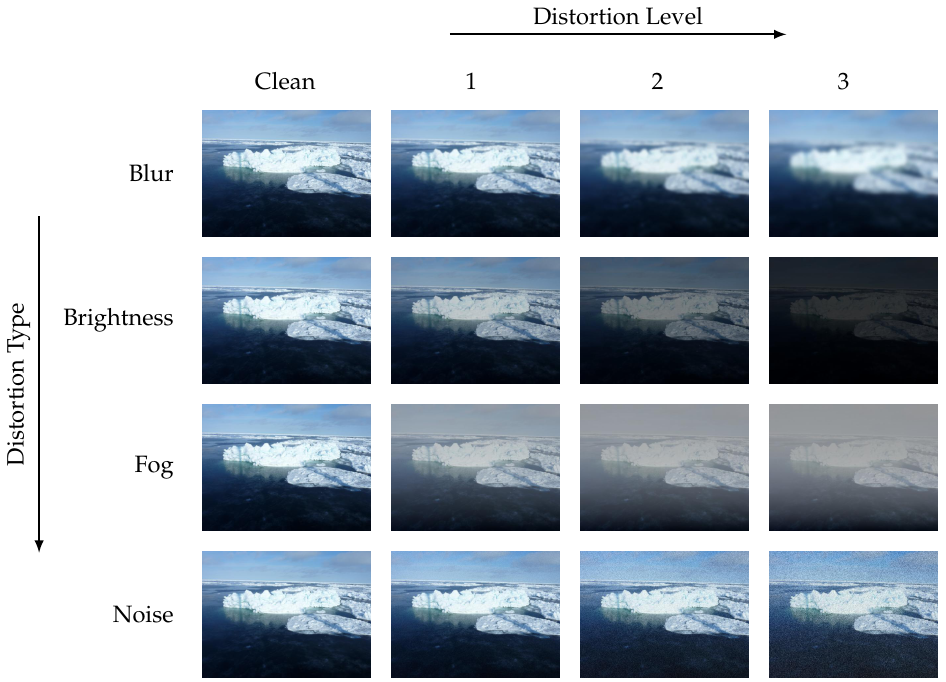
Figure 3. Sample of the different distortions and levels used in this work. Image rights: Sveinung Løset